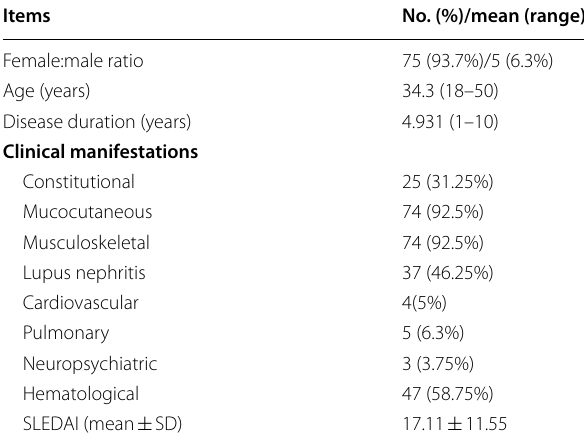
Table 1 Demographic and clinical manifestations of SLE patients